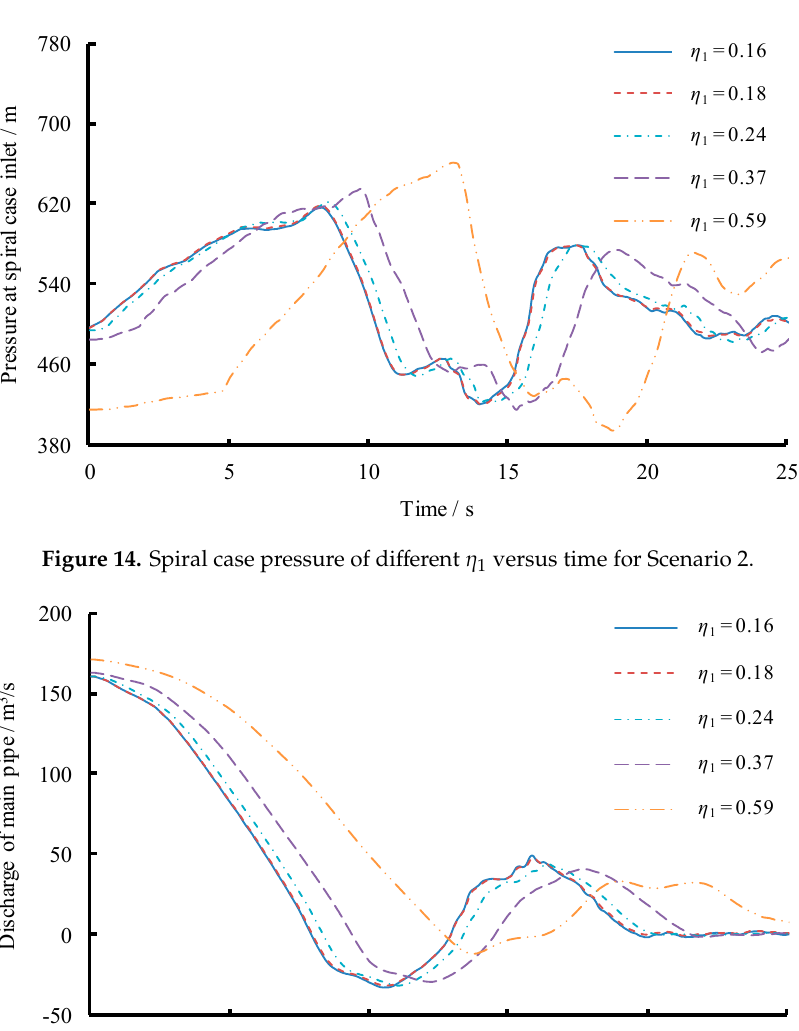
Figure 13. Maximum SCP with different time intervals of different η 1 for Scenario 2.